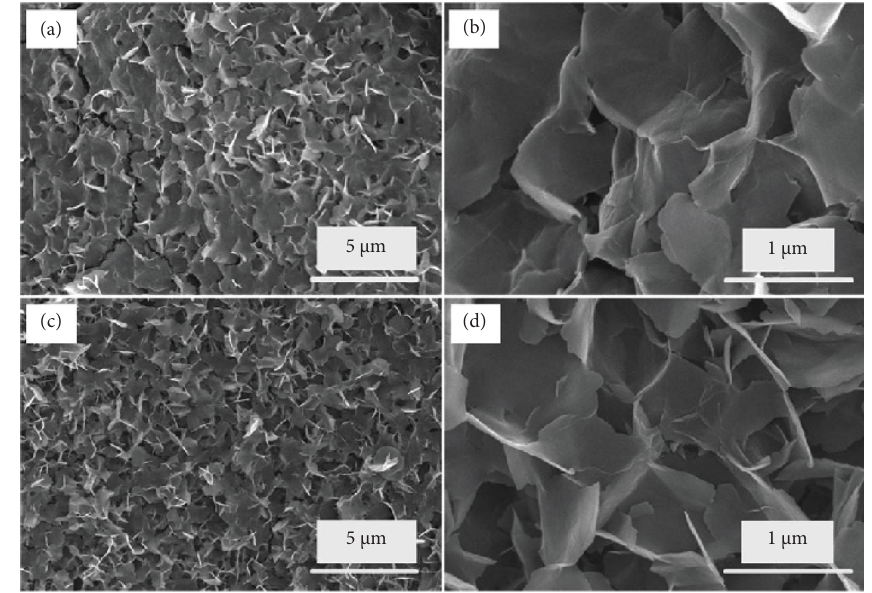
Figure 7: Electrodeposited Co(OH)